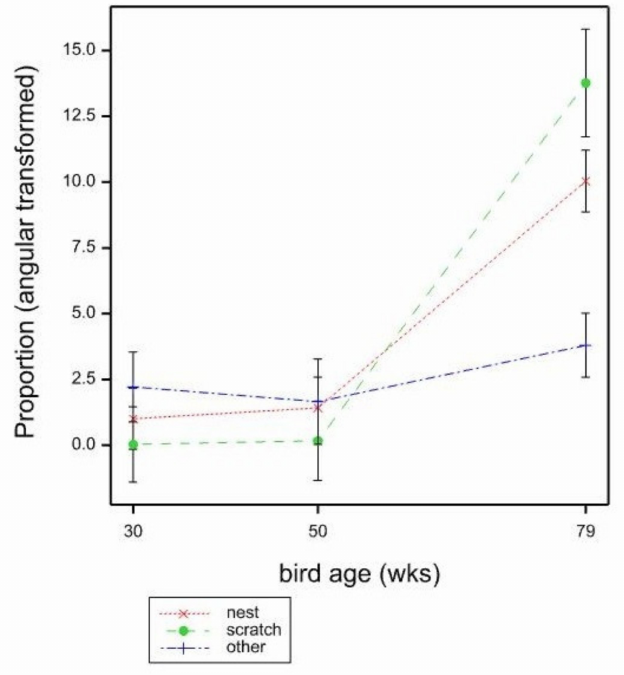
Figure 8. Mean proportions (angular transformed) of cracked eggs per location by bird age (weeks) and location in the cage (nest, scratch mat, all other areas) estimated from LMM. Mean SE 1.465.